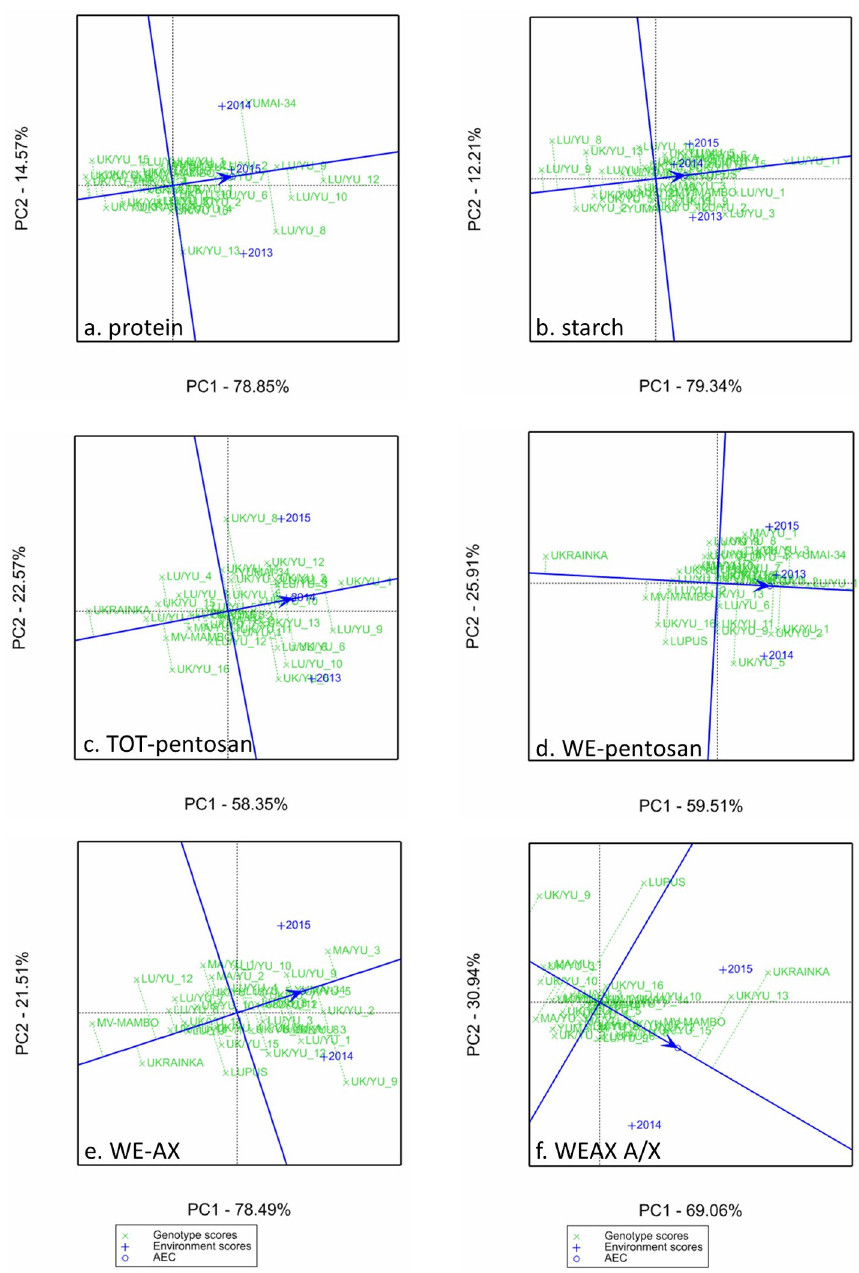
Fig 2. Stability of the 31 lines and their controls based on their compositional qualtity traits. (such as: protein content, starch content, total pentosan content (TOT-pentosan), water extractable pentosan content (WE-pentosan), water extractable arabinoxilan (WE-AX), arabinose/xylose ratio in WE-AX (A/X ratio) using GGE Biplot analysis (2013–2015). Although the CV values indicate whether a given trait of a genotype is stable under various environmental conditions, it does not show whether the value represents a consistently high or low performance. This information can be obtained from the GGE biplot analysis, in which the genotypes that fall in the right arrow of the AEC abscissa are those that perform best for a